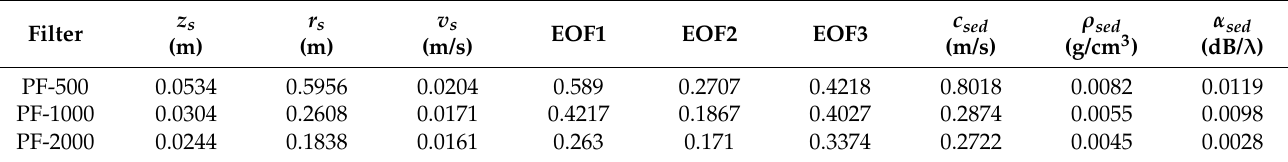
Table 5. TARMSE of improved-PFs for ASIAEX tracking results. Filter